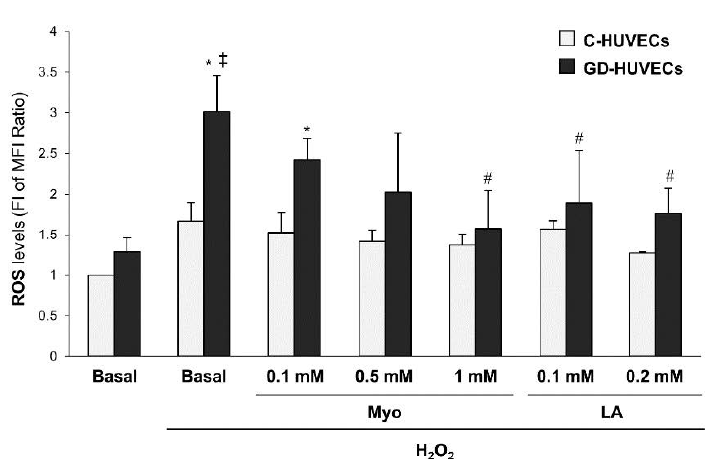
Figure 4. Effect of in vitro treatment with Myo on ROS levels in C- and GD-HUVECs. * p < 0.005 vs. Basal GD-HUVECs, ‡ p < 0.005 vs. H 2 O 2 C-HUVECs, # p < 0.05 vs. H 2 O 2 GD-HUVECs.